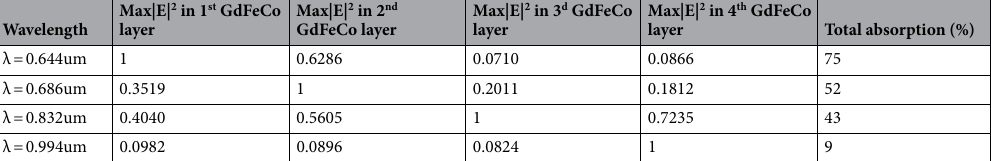
Table 2. The relative values of the maximum of |E| 2 in the magnetic layers at the operating wavelengths in case of the smooth 3 nm-thick GdFeCo